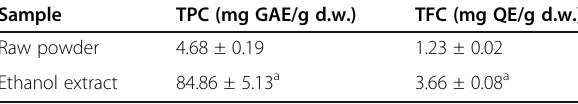
Table 2 TPC and TFC in the aerial parts of X. strumarium